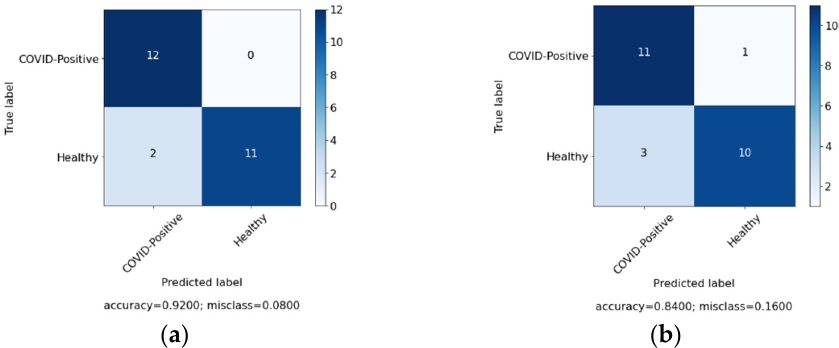
Figure 10. Diagnosis comparison for case 2 (CXR). ( a ) Expert diagnosis. ( b ) System diagnosis.